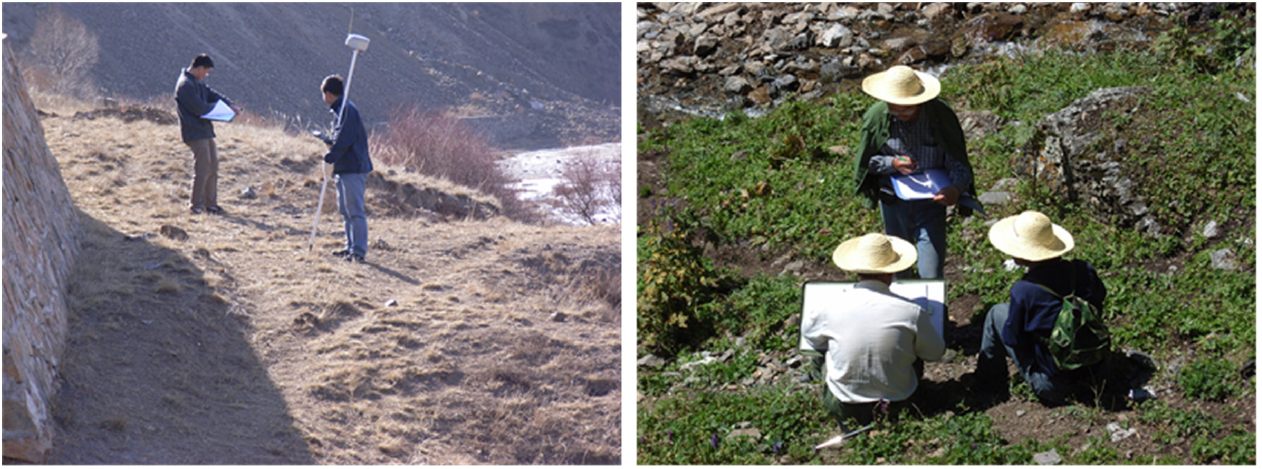
Figure 14. Traditional fieldworks in hydraulic engineering.